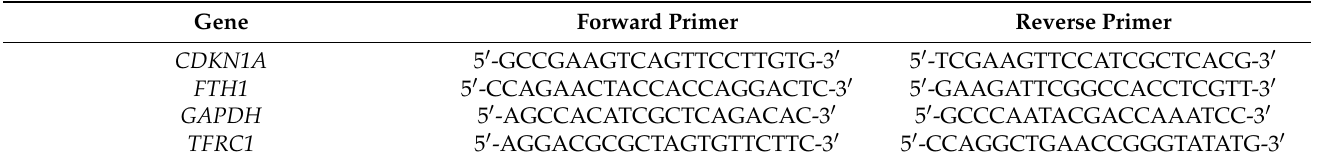
Table 2. Human gene primers for